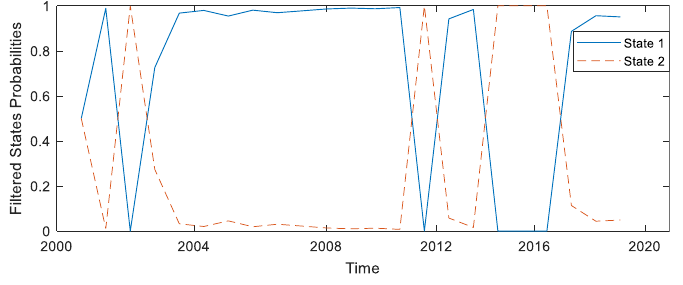
Figure 4. Markov state- transition diagram for China ’ s